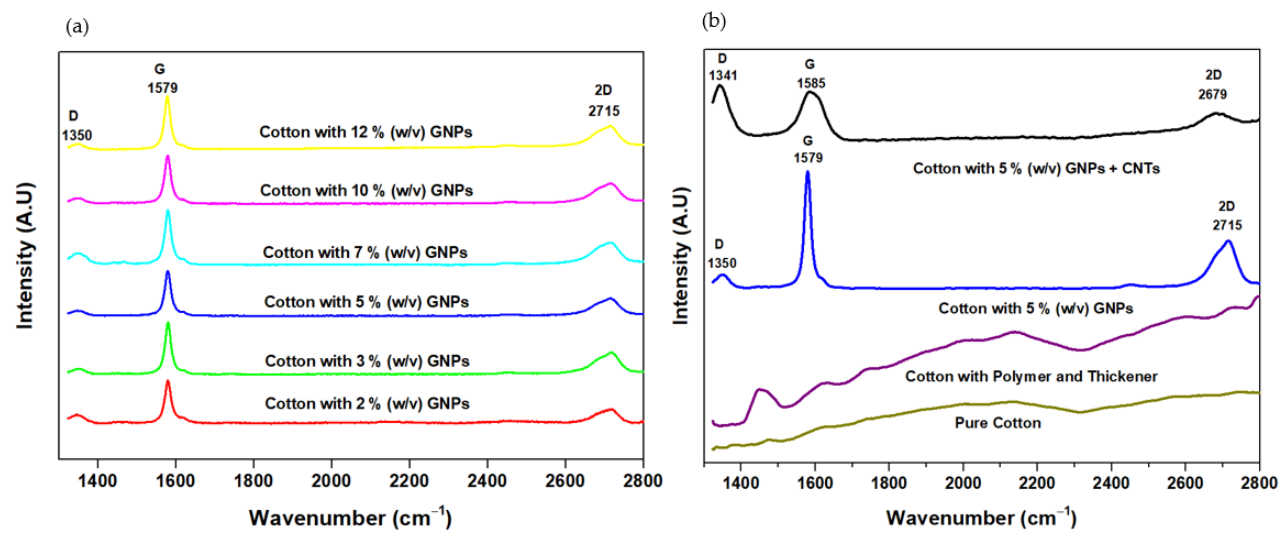
Figure 5. Raman spectra of various samples ( a ). Composition of GNPs varying from 2% ( w / v ), 3% ( w / v ), 5% ( w / v ), 7% ( w / v ), 10% ( w / v ) and 12% ( w / v ); ( b ). Pure cotton, cotton with polymer and thickener, 5% ( w / v ) GNPs and 5% ( w / v ) (GNPs + CNTs).